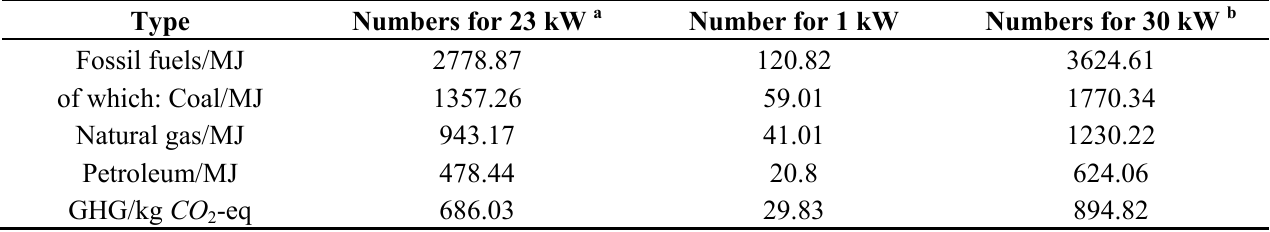
Table 9. Life cycle energy use and GHG emissions for the